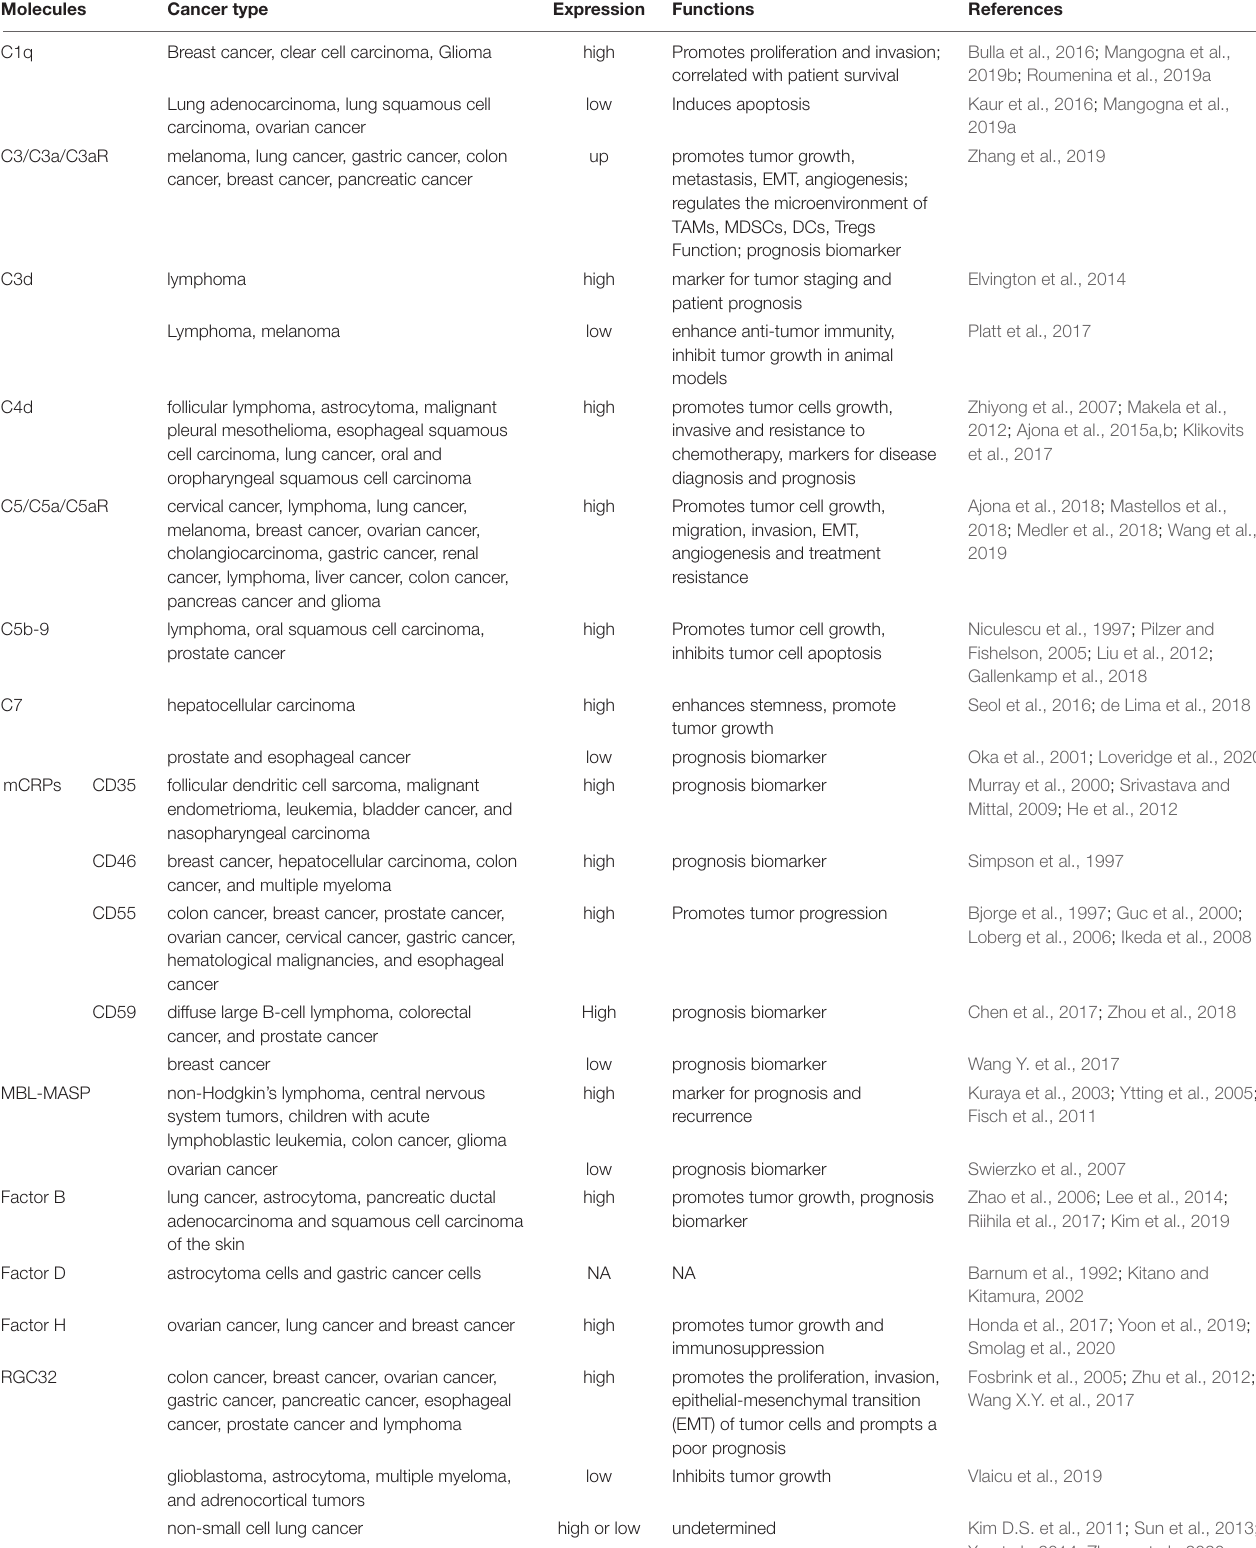
TABLE 1 | Complement components in